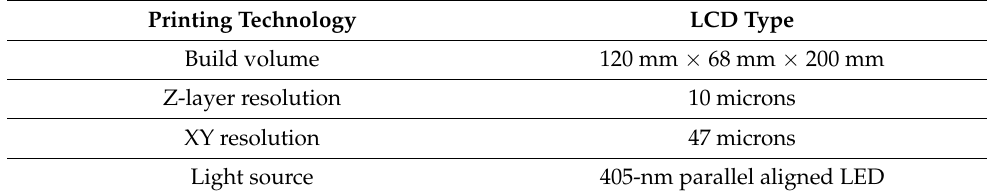
Table 2. Specifications of the 3D